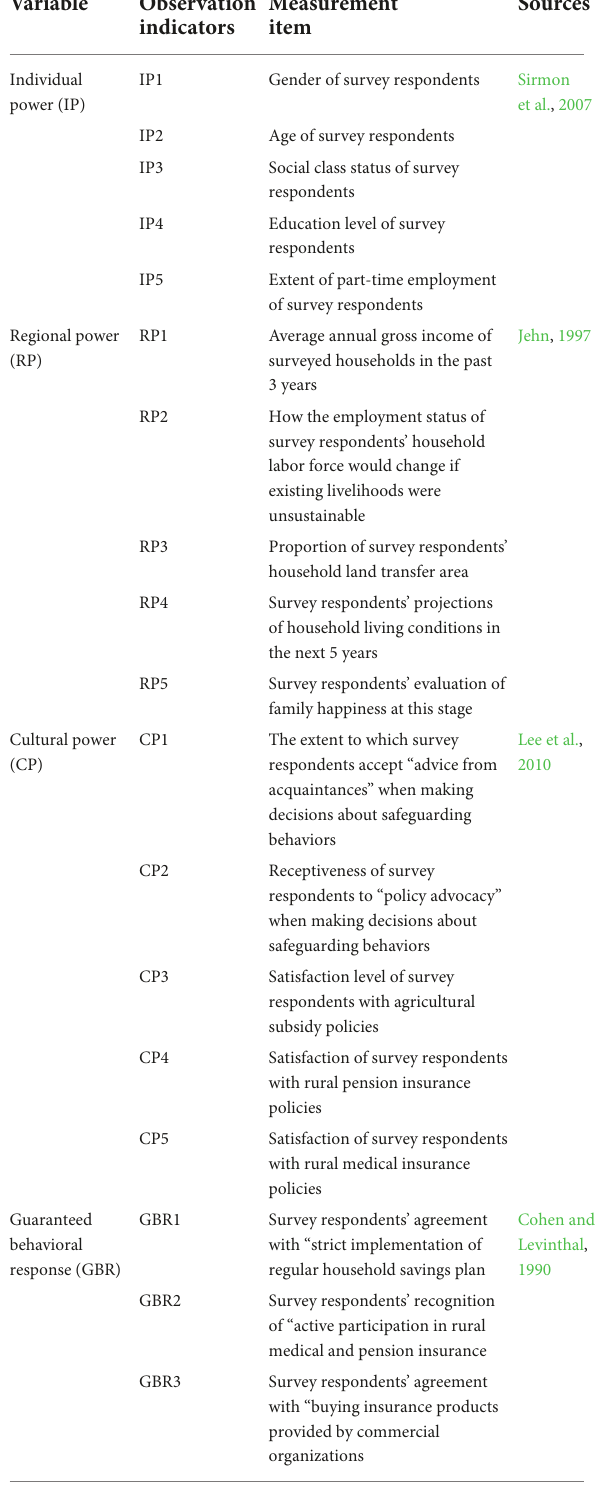
TABLE 2 Descriptive characteristics of the